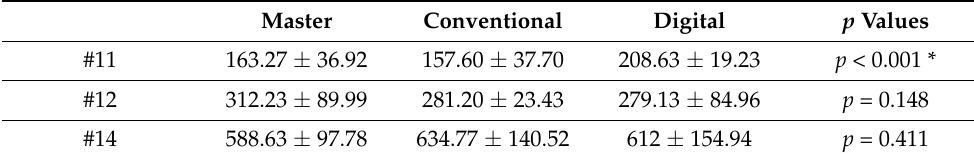
Table 1. Occlusal contact surface area (pixels) post image processing.